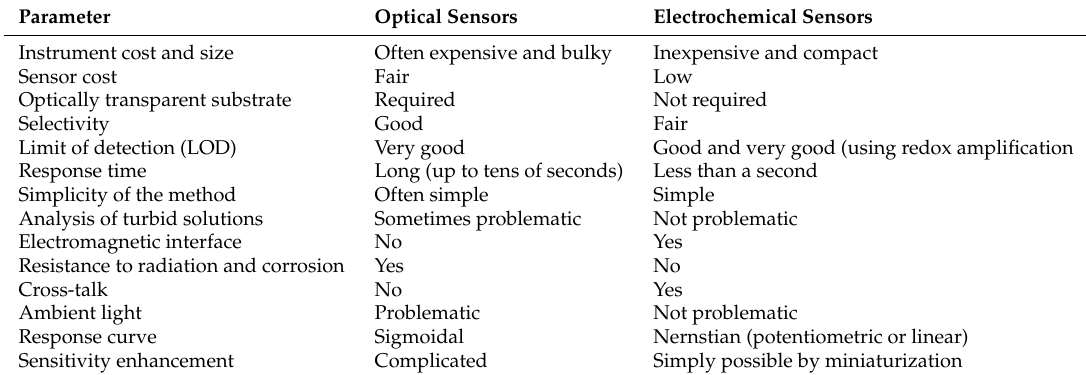
Table 2. Comparison of optical vs . electrochemical detection techniques, compiled from information in a book series by Madou